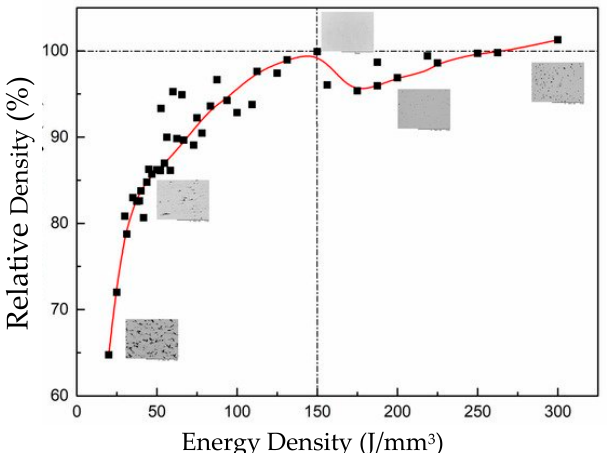
Figure 6. Relative density as a function of energy density [57]. Reused under Creative Commons Attribution License.